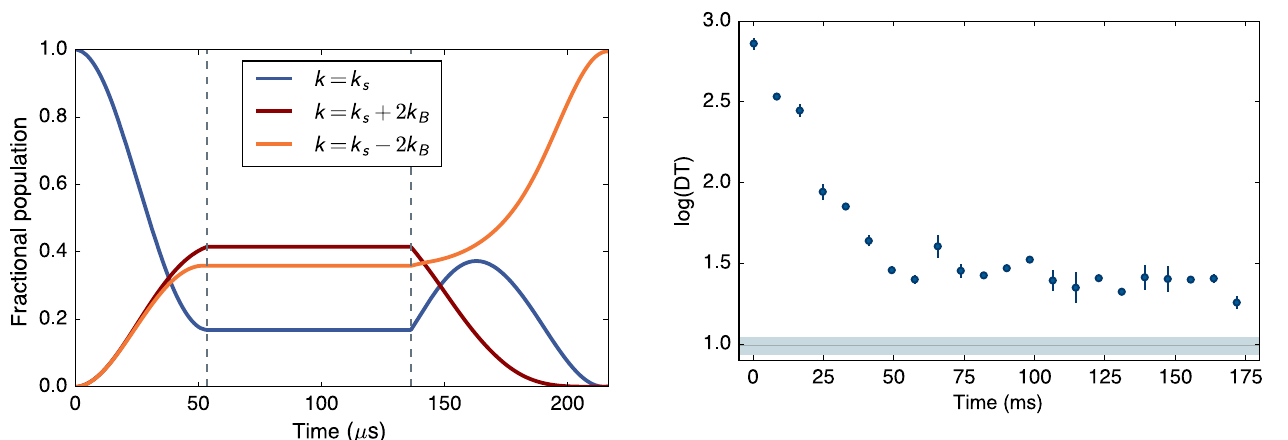
FIG. 13. Calculated time evolution of the fractional populations 2 k of the j ℏ ð k states and the undiffracted state j ℏ k s (cid:3) D Þi the single-sided kick pulse sequence. See text for detailed settings for each parameter.